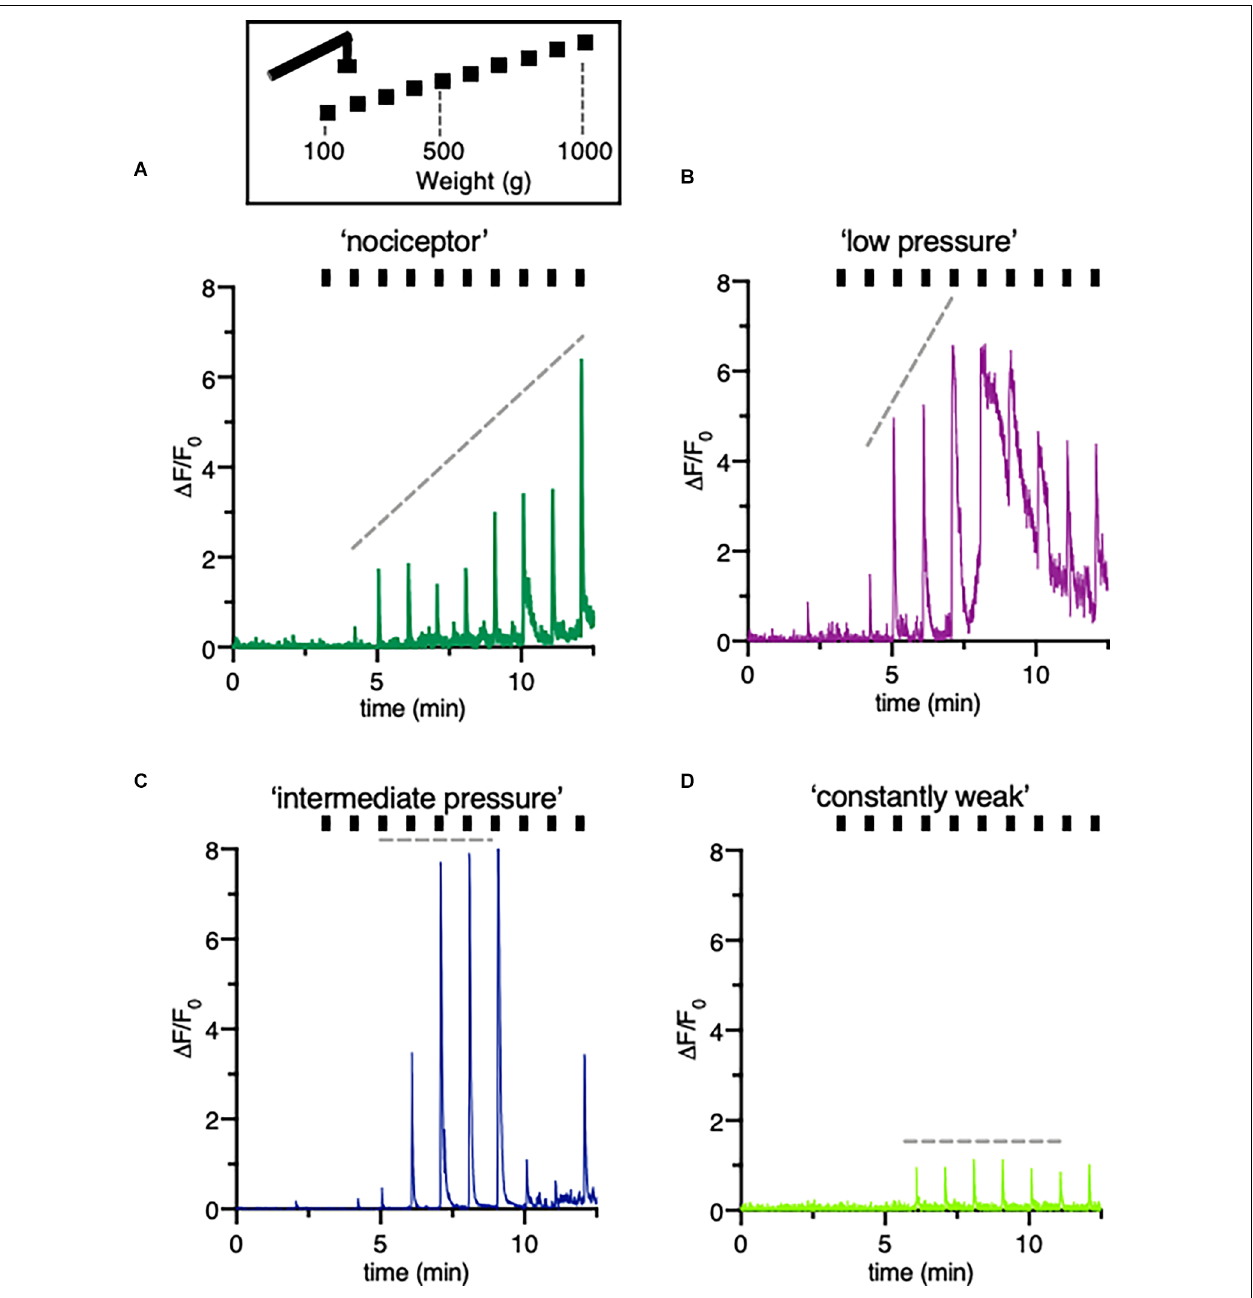
FIGURE 4 | Classification of different type of DRG neurons responsive to increasing pressure. (A–D) Schematic drawing of the mechanical stimulation protocol and example trace indicating a variety of fluorescence responses taken from individual neurons of a mouse treated with vehicle only. The hindpaw was stimulated with increasing pressure started at 100 g to a maximum of 1,000 g. Different patterns of changes in intracellular calcium concentrations reflect distinctive cell types, here called “nociceptors” (A) “low pressure” responders (B) “intermediate pressure” responders (C) and “constant weak” (D) responders. Ticks correspond to mechanical stimulation